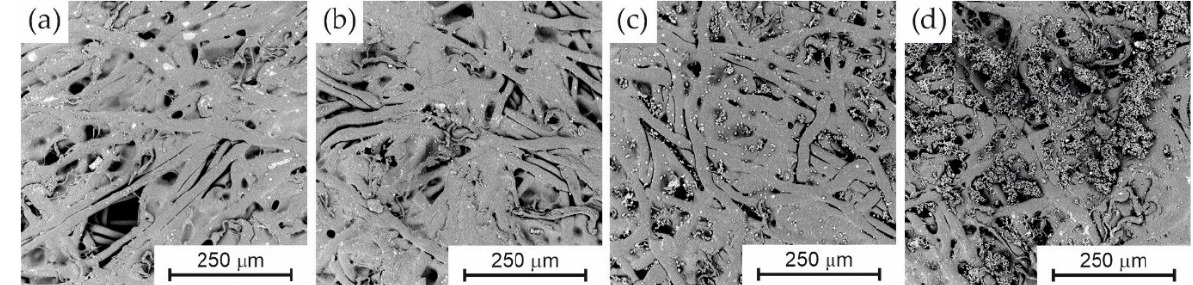
Figure 3 . SEM images of the outer side of cylindrical membranes for different modifications. ( a ) PVDF unmodified, ( b ) PVDF + 20% PEG, ( c ) PVDF + 20% PEG + 5% CaCO 3 , and ( d ) PVDF + 20% PEG + 10% CaCO 3 .